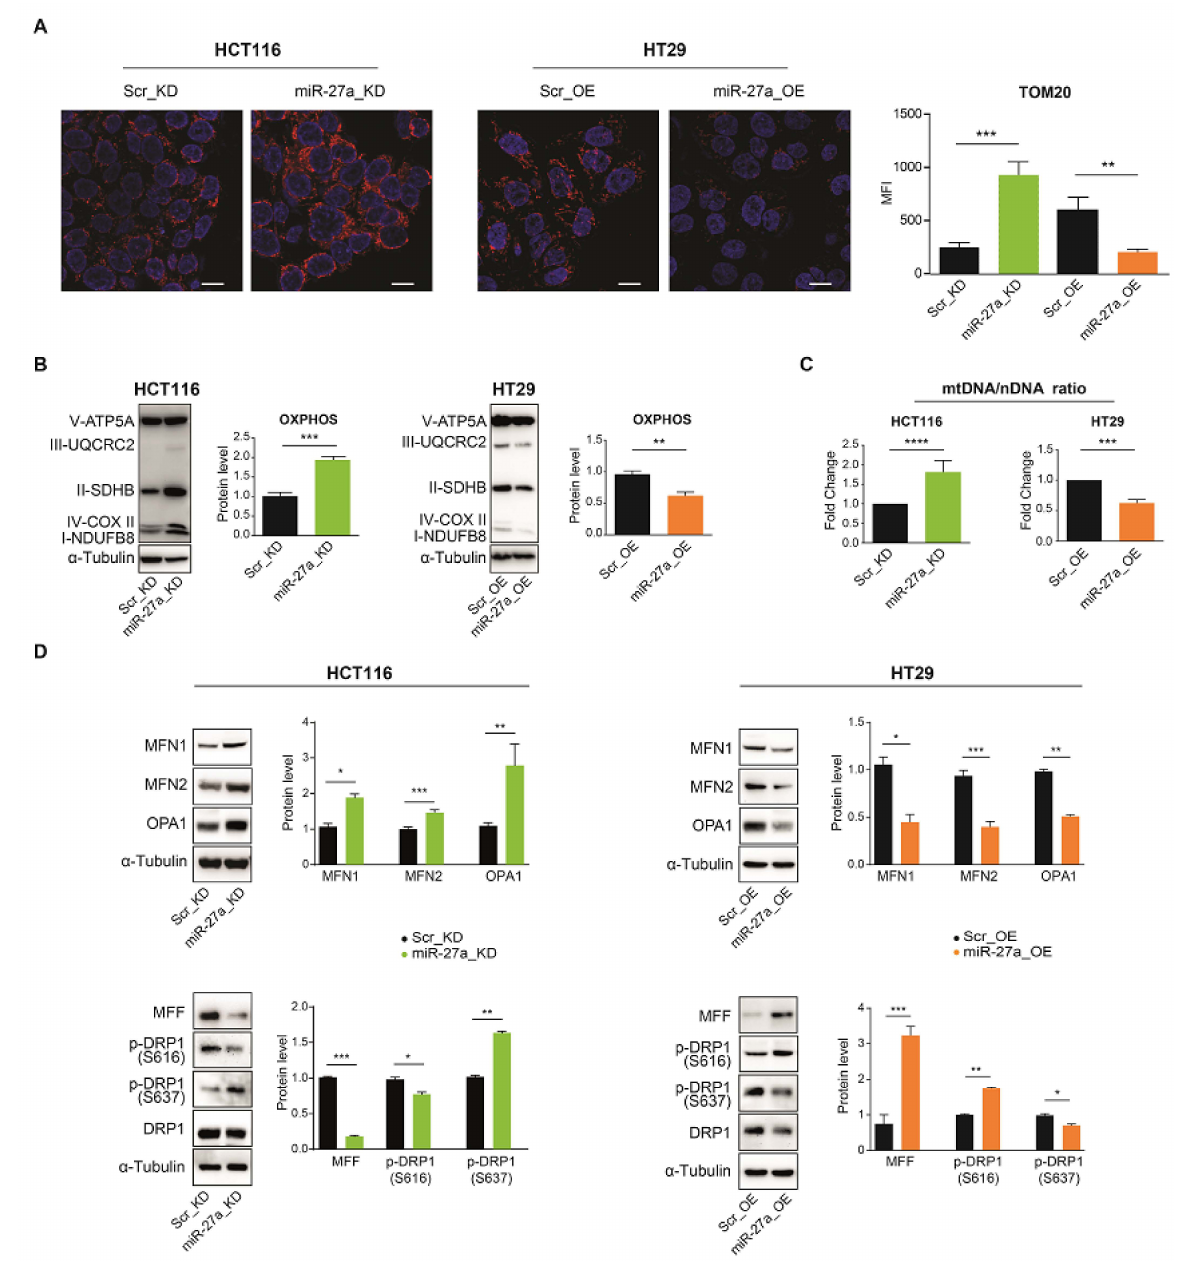
Figure 3. The miR-27a/FOXJ3 axis affects mitochondrial abundance in the CRC cell model system in vitro. ( A ) Im- munofluorescence analysis of TOM20 in miR-27a_KD and miR-27a_OE and the corresponding Scr_KD and Scr_OE controls (magnification: 63 × ; scale bar: 5 µ m). The panel on the right illustrates the relative quantification as mean fluorescence intensity (MFI). ( B ) Representative immunoblots in the same cells as in ( A ) performed for the proteins ATP5A, UQCRC2, SDHB, COX II, and NDUFB8 belonging to the respiratory chain complexes V, III, II, IV, and I, respectively. The histograms report the overall OXPHOS protein quantification with respect to α -tubulin as a loading control. ( C ) Evaluation of the mito- chondrial DNA/nuclear DNA ratio (mtDNA/nDNA ratio) by qPCR. Data are relative to the mean ± SEM of experiments performed at least in triplicate and expressed as fold-change with respect to the corresponding control cells. ( D ) Analysis of mitochondrial dynamics: Western blot analysis of MFN1, MFN2, and OPA1 as representative of fusion markers (upper panel) and MFF, p-DRP1 (S616), p-DRP1 (S637), and DRP1 as representative of fission markers (lower panel) in the same cells as in ( A ). Panels ( B ) and ( D ) show representative results of at least two performed experiments, normalized to the mean ± SEM, and expressed as protein levels with respect to α -tubulin as a loading control. The α -tubulin shown is from a representative experiment. Statistical significance was considered when * p ≤ 0.05, ** p ≤ 0.01, *** p ≤ 0.001, or **** p ≤ 0.0001 ( t -test). File S1: Original Western